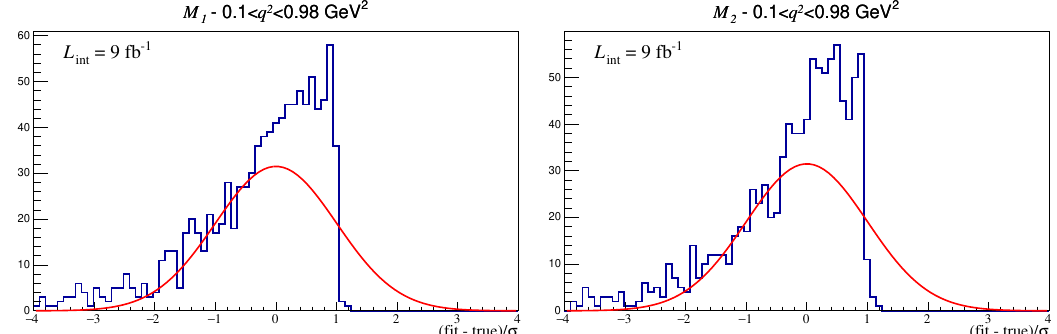
Figure 13 . Summaries of the (green) means and (blue) standard deviations of the pull distribution for the CP -asymmetry observables and the relative branching fraction, denoted rel. BF , in two bins of q 2 . The red lines are references at 0 and 1.